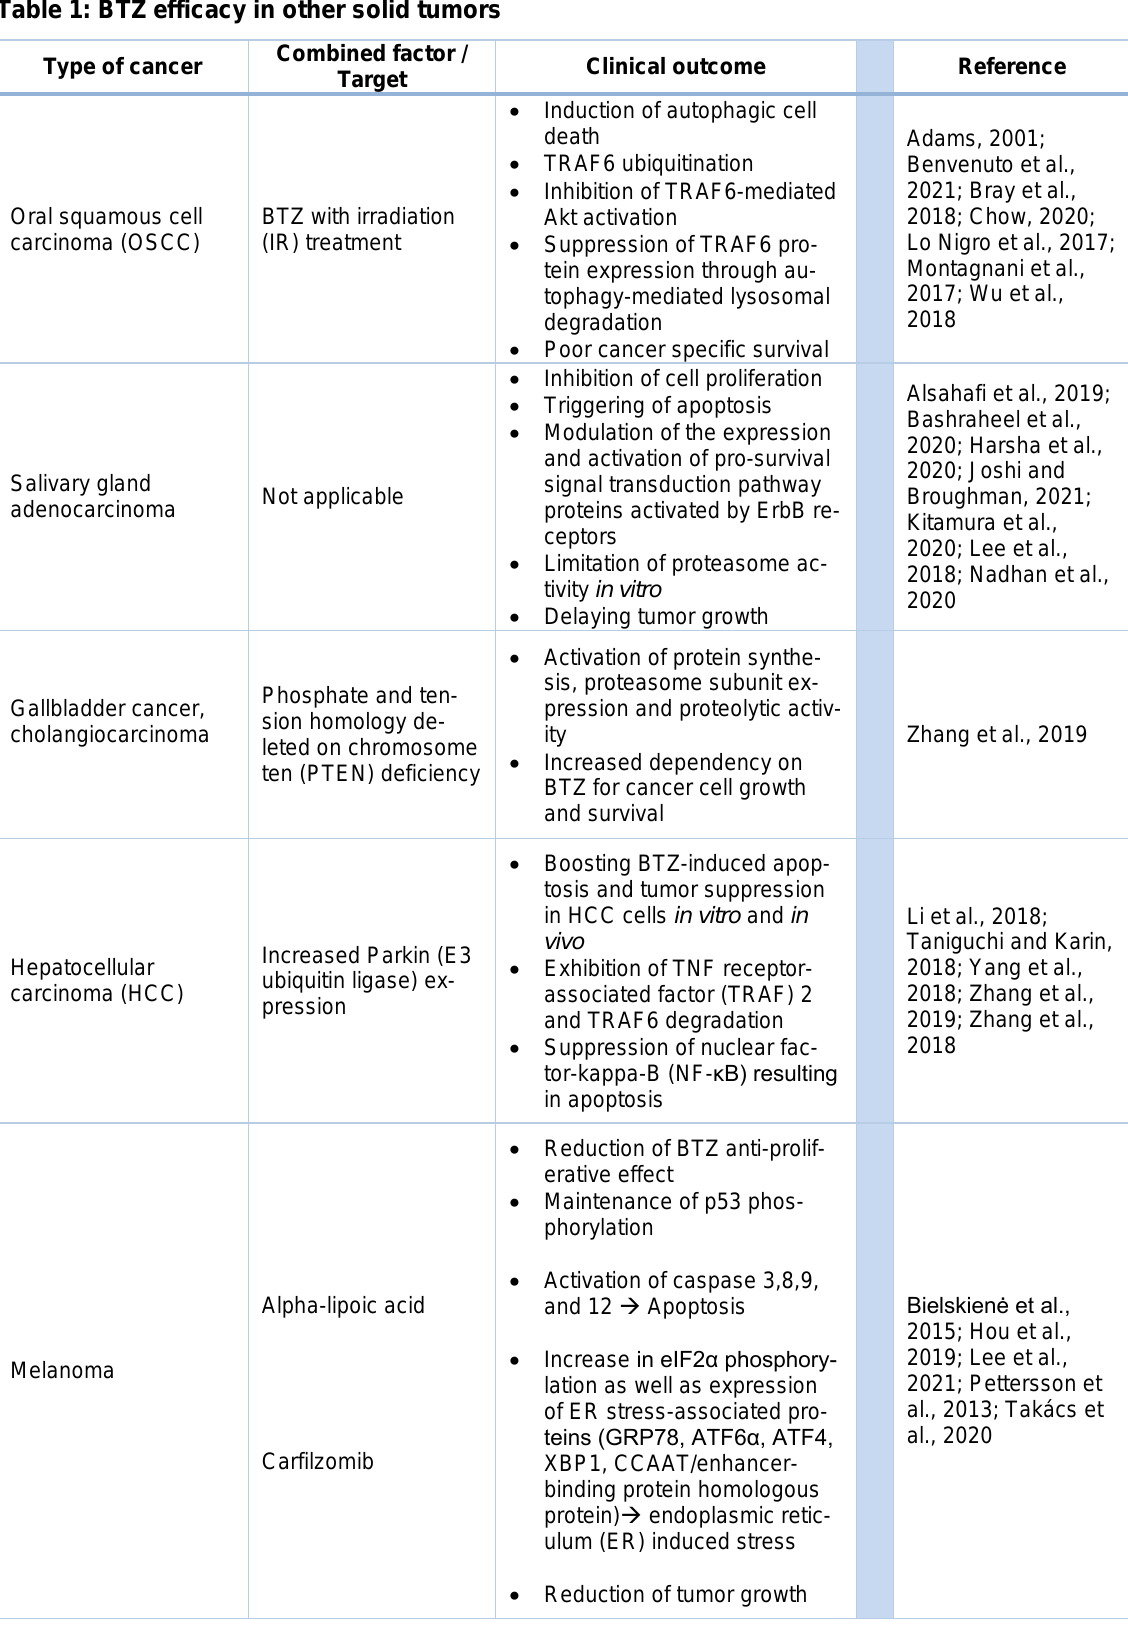
Table 1: BTZ efficacy in other solid